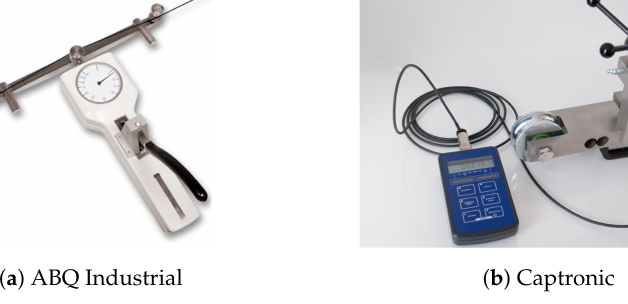
Figure 1. Examples of commercial off-the-shelf devices for measuring cable